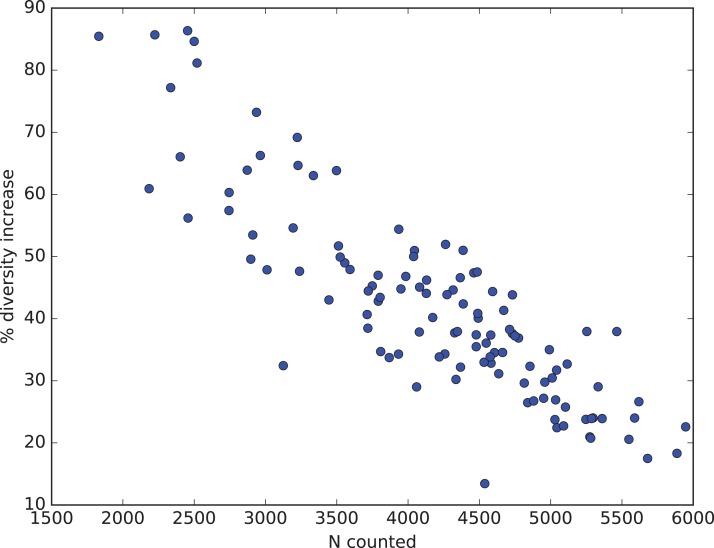
Percent diversity capture improvement from rare mode counting.Relationship in Neogene radiolarian data (Renaudie, 2012; Renaudie & Lazarus, 2013; Renaudie, this paper: full data and script in SOM Appendix S4) between number of specimens actually counted (x-axis) and percent improvement in total observed diversity (species richness, y-axis) by using Raritas and switching to rare count mode when the count total in a sample reached between 1,000 and 2,000 specimens. Improvement values are calculated for each sample by estimating how many species would have been found using the same total count for the sample but not using rare count mode, and are calculated by rarefaction from the observed diversity and count values (values are means based on 1,000 replicates).